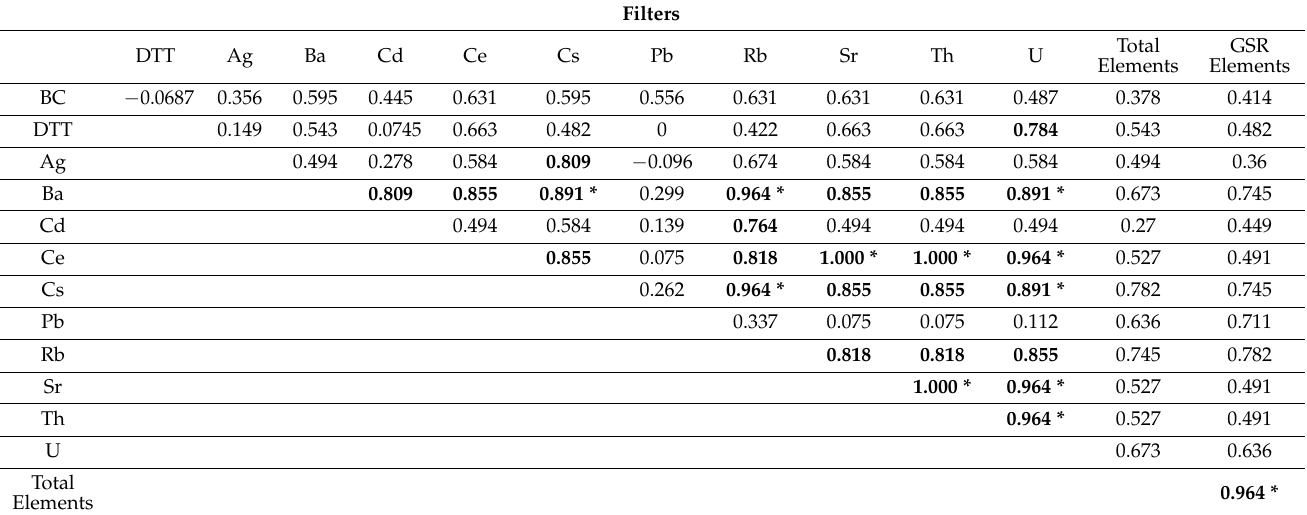
Table 2. Associations by Sample